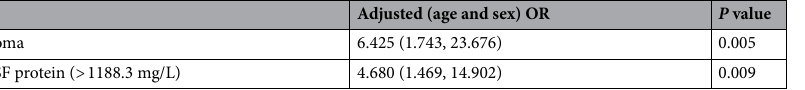
Table 2. Age- and sex-adjusted OR for risk factors associated with poor outcome in childhood tuberculous meningitis. TBM tuberculous meningitis, OR odds ratio, CI confidence